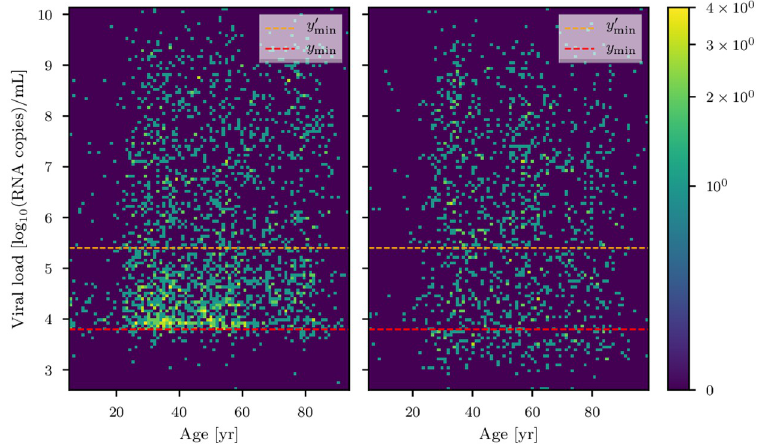
Fig 1. The cobas (left) and the LC 480 (right) datasets. The lower thresholds y min and y 0 been filtered are shown in red and orange, respectively. The number of data counts is color coded with a logarithmic color scheme (see colorbar).